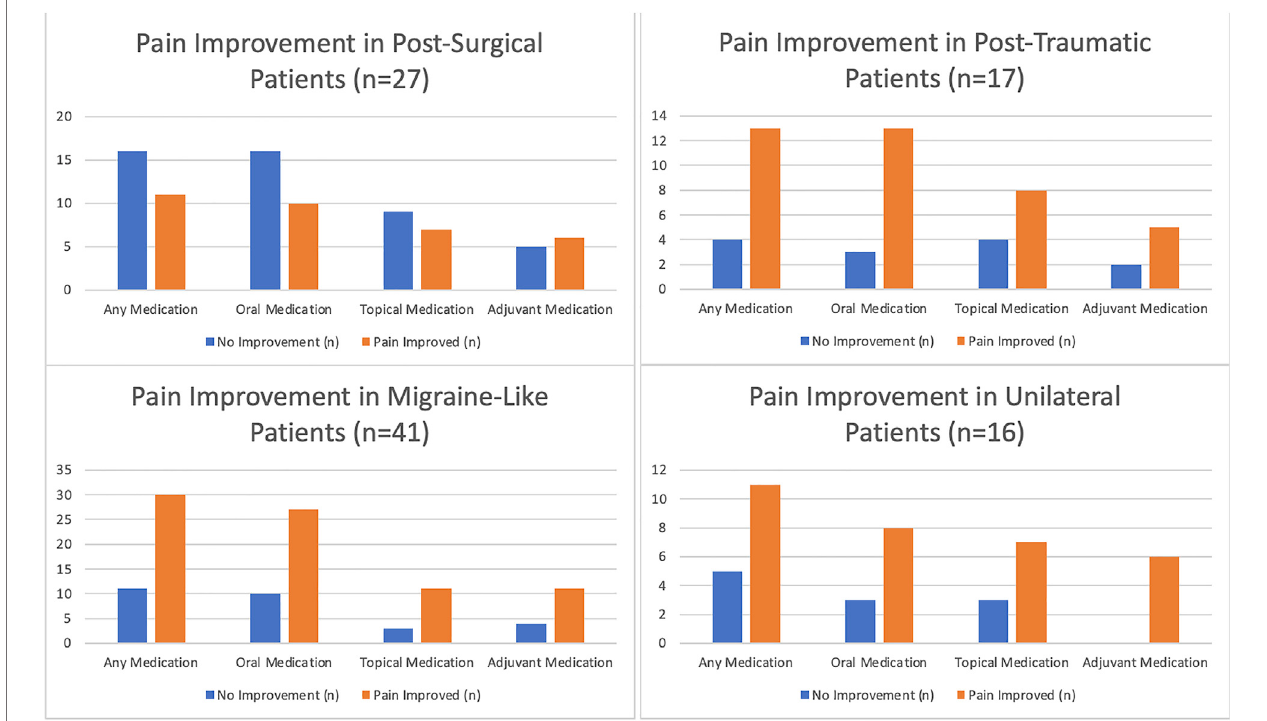
FIGURE 1 | Pain response to various treatment strategies in patients with neuropathic pain, by underlying cause.